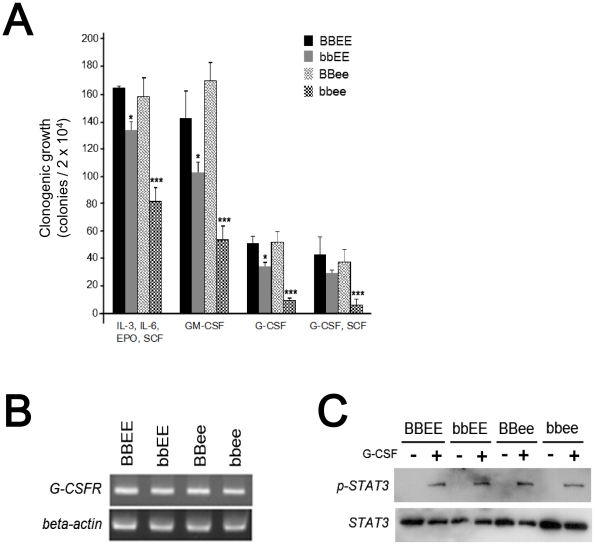
Characterization of hematopoietic cells in C/EBPβ−/−C/EBPε−/− mice.(A) Colony assay in methylcellulose. Light-density, mononuclear bone marrow cells (2×104) were cultured in 1% methylcellulose supplemented with either IL-3 (10 ng/mL), IL-6 (10 ng/mL), SCF (20 ng/mL), and EPO (3 U/mL); or GM-CSF (20 ng/mL); or G-CSF (60 ng/mL); or G-CSF (60 ng/mL) and SCF (20 ng/mL). Colonies were scored if they contained ≥50 cells at day 7 of culture. Results represent the mean ± SD of 3 mice. (B) Expression of G-CSF receptor (G-CSFR) in mononuclear bone marrow cells. Expression of G-CSFR mRNA was examined by RT-PCR. β-actin was used as an internal control. (C) Expression of STAT3 in mononuclear bone marrow cells. The cells were stimulated either with or without G-CSF (100 ng/mL) for 30 min. Levels of phospho-STAT3 (pSTAT3) and STAT3 were detected by Western blot analysis.